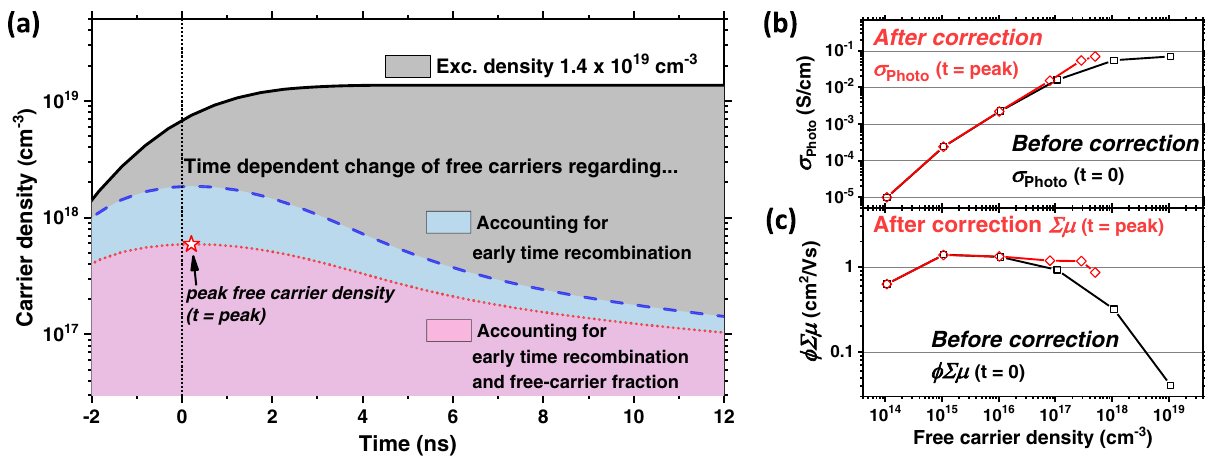
Fig. 3 Elucidating the effect of free-carrier density on optoelectronics properties of FACs perovskite thin fi lms. a Photo-induced carrier population changes as a function of time: Assuming all absorbed photons lead to free-carriers (black solid line, also represents Supplementary Fig. 6a) and assuming free-carrier density reduced by early-time recombination (blue dashed line, also represents Supplementary Fig. 6b), and assuming free-carrier density reduced by early time recombination and exciton-to-free-carrier-ratio (red dotted line, also represents Supplementary Fig. 6c). Star symbol is a corresponding time (ns) for peak free-carrier density. b Photo-conductivity before ( σ Photo t ¼ 0 ð Þ , black square) and after ( σ Photo t ¼ peak ð Þ , red diamond) correction as a function of free-carrier density. c Charge carrier mobility before ( ϕΣμ t ¼ , black square) and after ( Σμ t ¼ , red diamond) correction as a 0 ð Þ peak ð Þ function of carrier density, respectively, determined by TPC. All lines (3b – c) are only to guide the